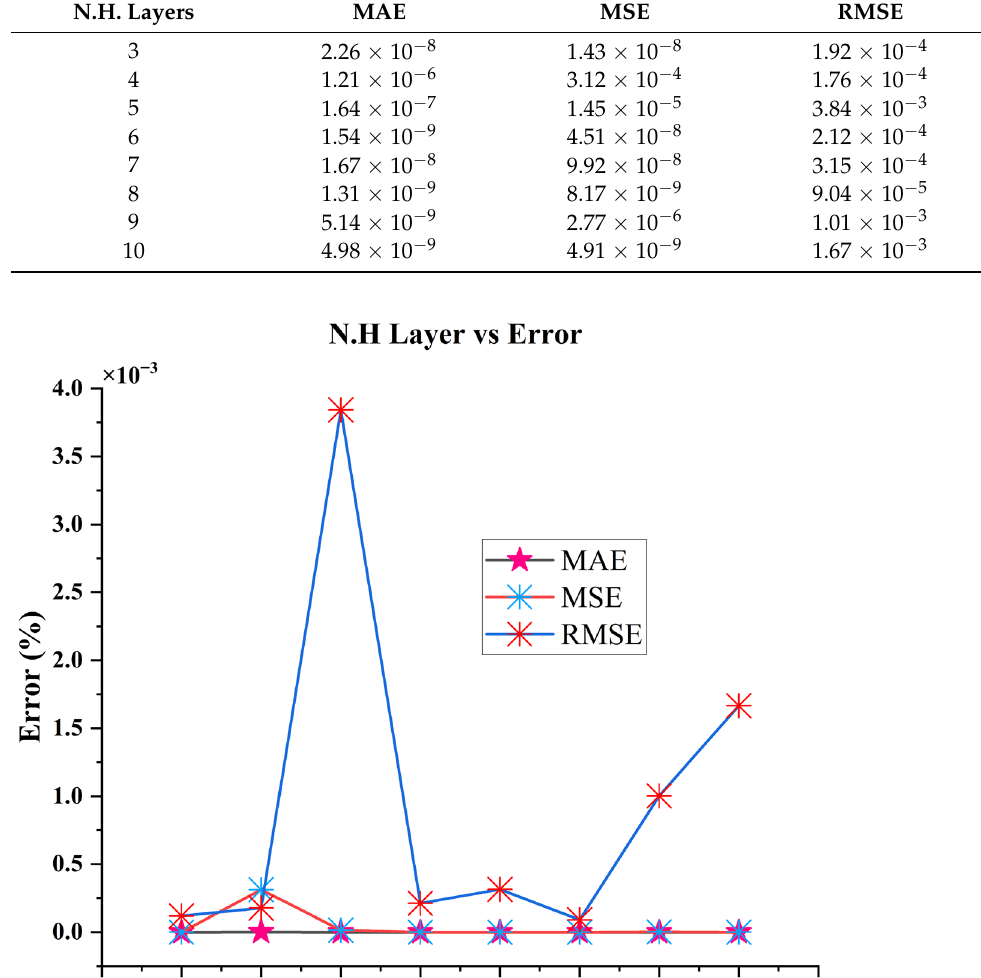
Table 4. The MAE, MSE, and RMSE values with the hidden layers ranged between (3–10). N.H. Layers